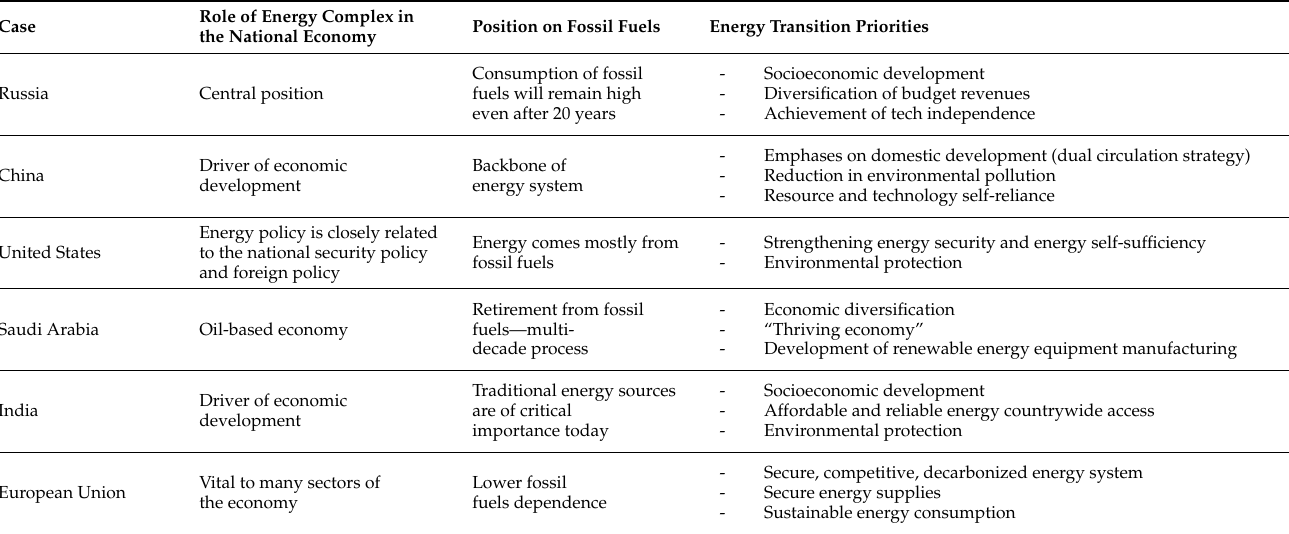
Table 4. Key features and energy priorities of selected country